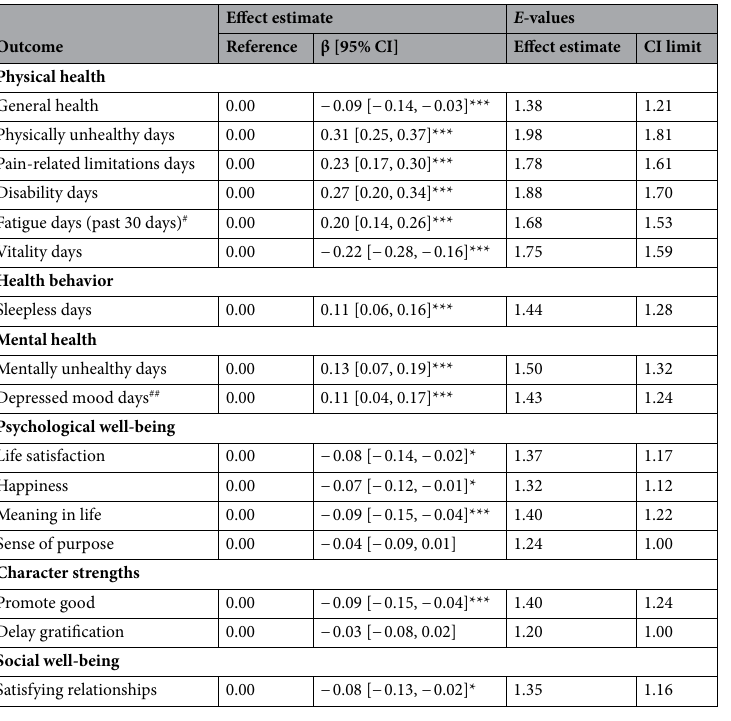
Table 3. Associations of overall suffering (T1) with health and well-being outcomes (T2) in Study 2 (flight attendant sample). β standardized effect size, CI confidence interval. n = 1402 for all analyses. Multiple imputation was performed to impute missing data on the exposure, covariates, and outcomes. We ran a linear regression model to estimate a β for all outcomes (one outcome at a time). Each outcome was continuous and standardized ( M = 0, SD = 1). All models adjusted for prior values of age, gender, sexual orientation, racial status, marital status, educational attainment, job tenure, child dependents, and older adult dependents assessed at T1. Unless otherwise indicated, all models also adjusted for the prior value of the respective outcome assessed at T1. If a prior value of an outcome was not available, we adjusted for the prior value of a variable that was most comparable to the outcome: # fatigue days (past 7 days), ## depression symptoms (see Supplemental Table S10). *p < 0.05 before Bonferroni correction, *** p < 0.05 after Bonferroni correction (the p -value cutoff for Bonferroni correction was 0.05/16 = 0.003 for each